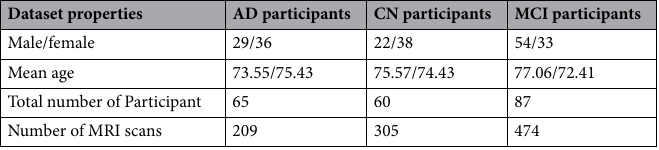
Table 1. Participants’ demographics and MRI